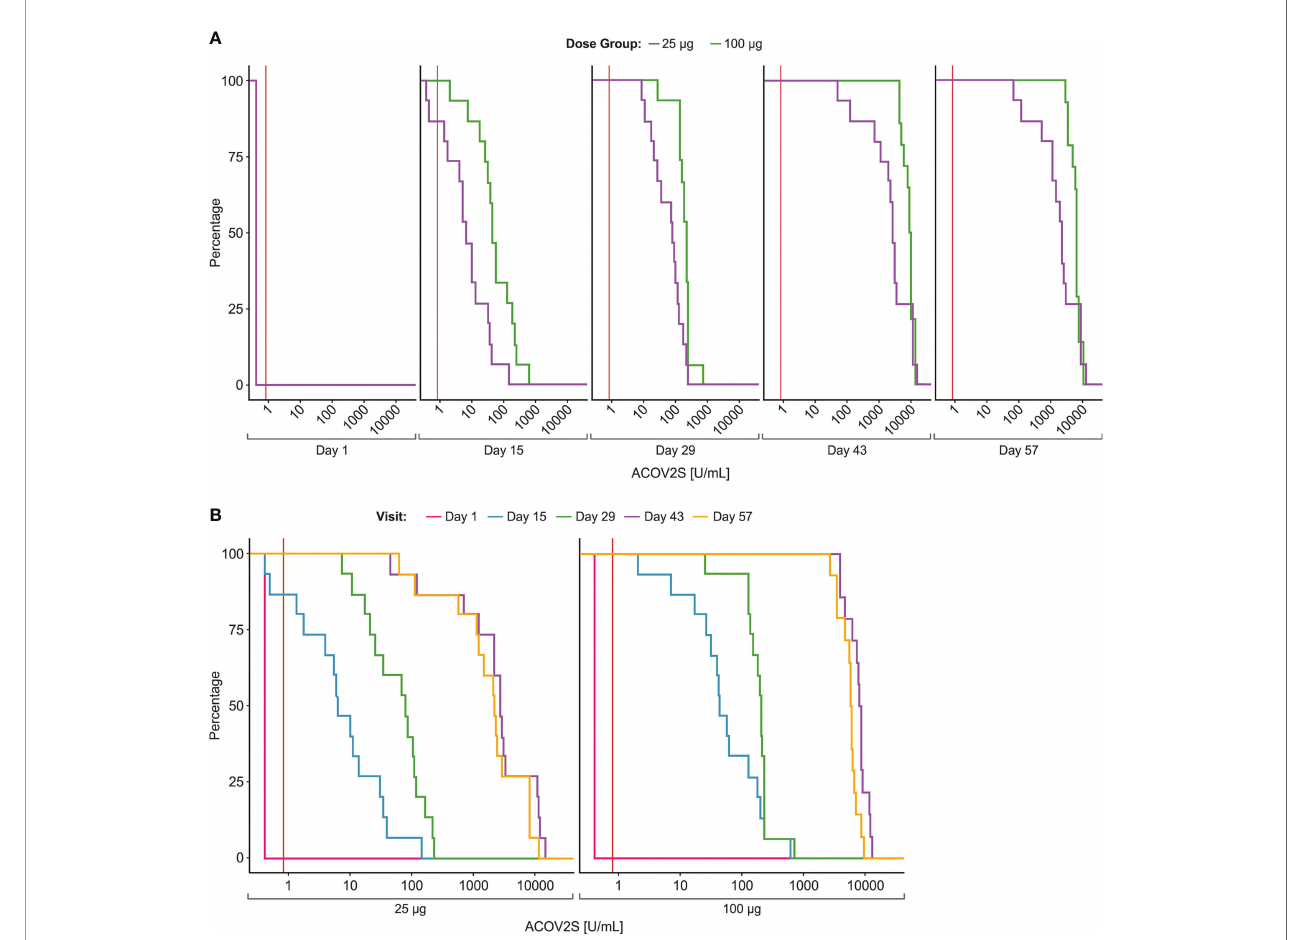
FIGURE 1 | Time-dependent antibody responses as measured by the ACOV2S. Reverse cumulative distribution curves allow for comparison of ACOV2S-measured antibody level distributions between dose groups (A) and visit days (B) . Red vertical line indicates reactivity cut-off (0.8